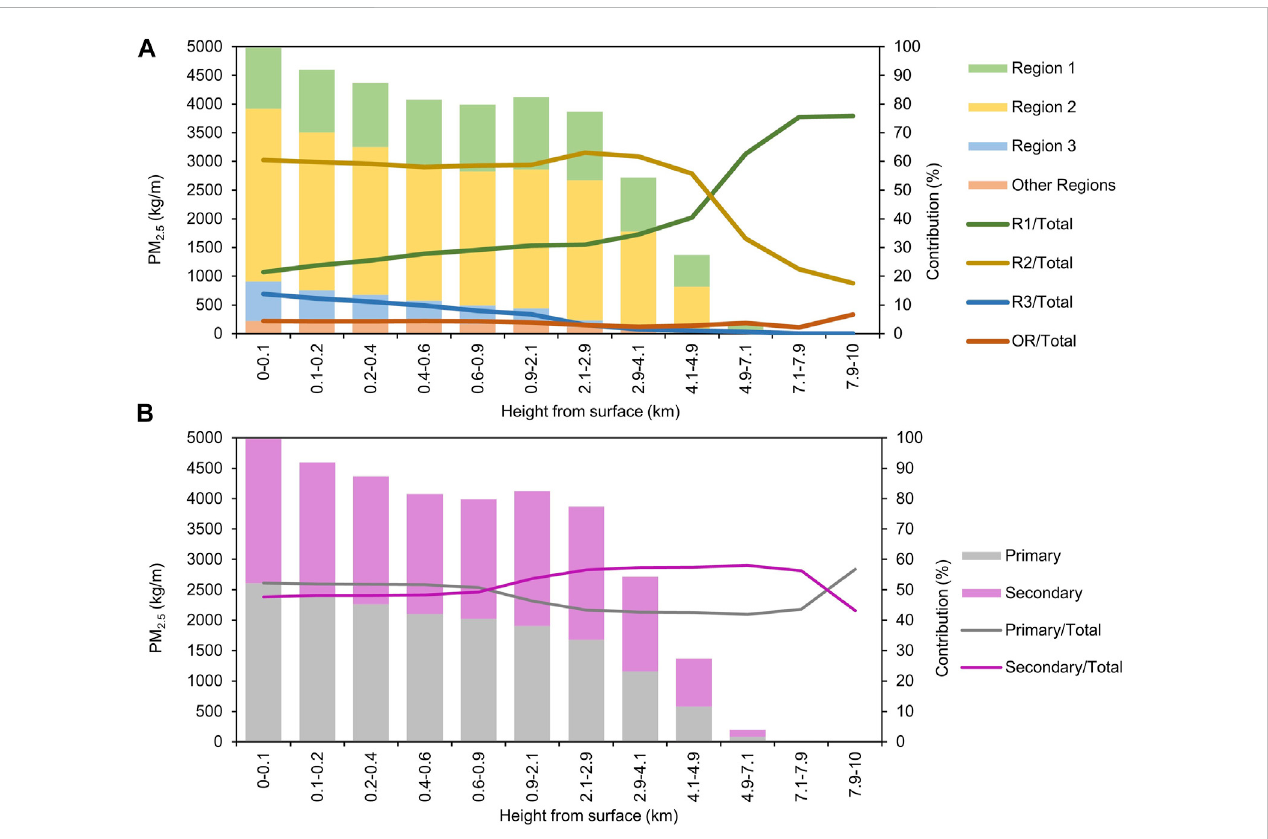
FIGURE 12 The mean per unit PM 2.5 mass quality (kg/m) at different heights in Yunnan Province (A) from biomass burning in different regions [Region 1, 2, 3 (R1, R2, R3) and other regions (OR)] and (B) produced by primary emission and secondary formation of biomass burning in Southeast Asia during 28 March to 2 April